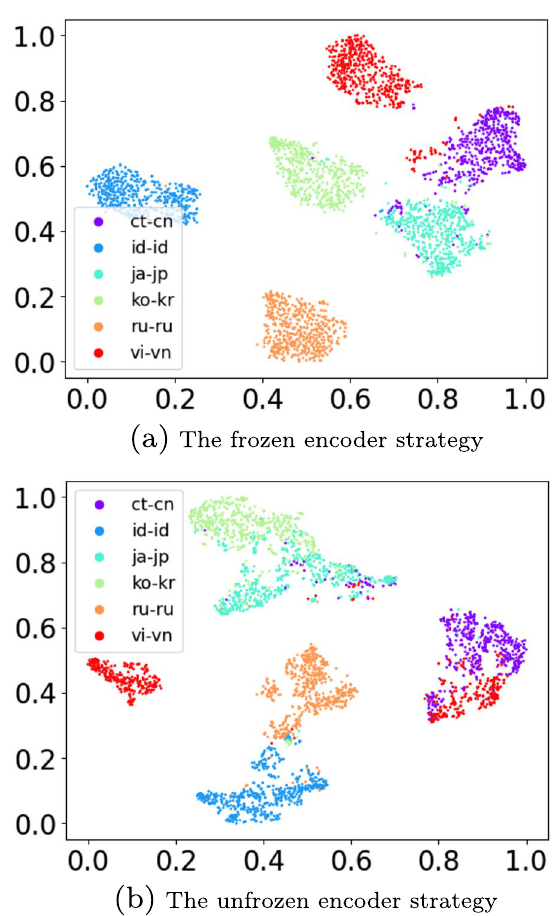
Fig. 2 The visualization results of language space trained with a frozen encoder strategy ( a ) and an unfrozen encoder ( b ) strategy, respectively